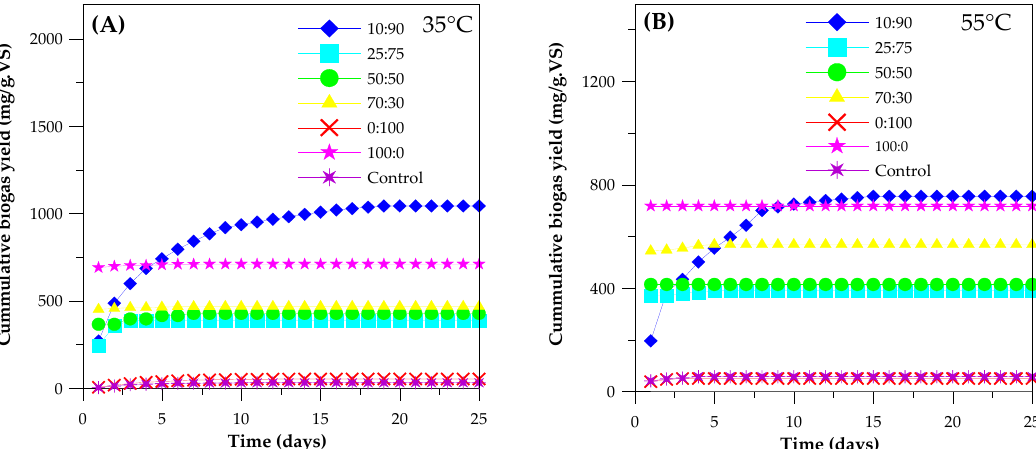
Environments 2019 , 6 , x FOR PEER REVIEW Figure 1. Daily biogas yield during co-digestion of canteen food waste and domestic wastewater in batch experiments at ( A ) a mesophilic temperature and ( B ) a thermophilic temperature.